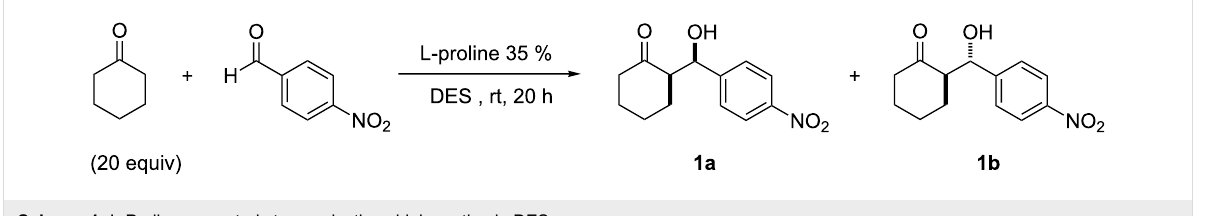
Scheme 1: L-Proline-promoted stereoselective aldol reaction in DES.